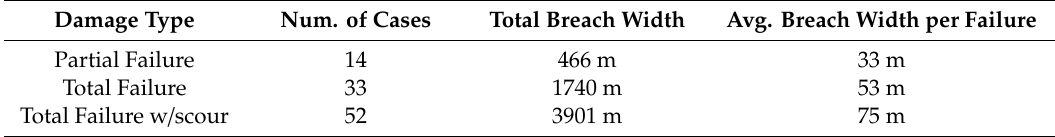
Table 3. Breach width analysis per damage type, Germany 2002 and 2013.